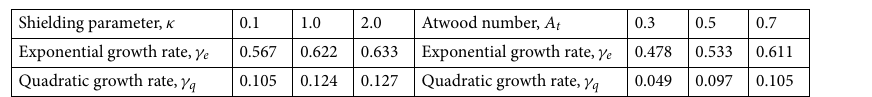
Figure 6. Effect of screening parameter κ [sub-figure ( a )] and Atwood number A t [sub-figure ( b )] on single- mode RTI. In both sub-figures, subplots ( i )–( v ) show the time evolution of instability from linear ( t = 100 ω − 1 to nonlinear stages t = 1500 ω − pl s. Sub-figure ( a ): first to third rows represent growth of RTI for κ = 2 . Sub-figure ( b ): first to third rows represent growth of RTI for A t = 0.3, 0.5 and A t = 0.7 .